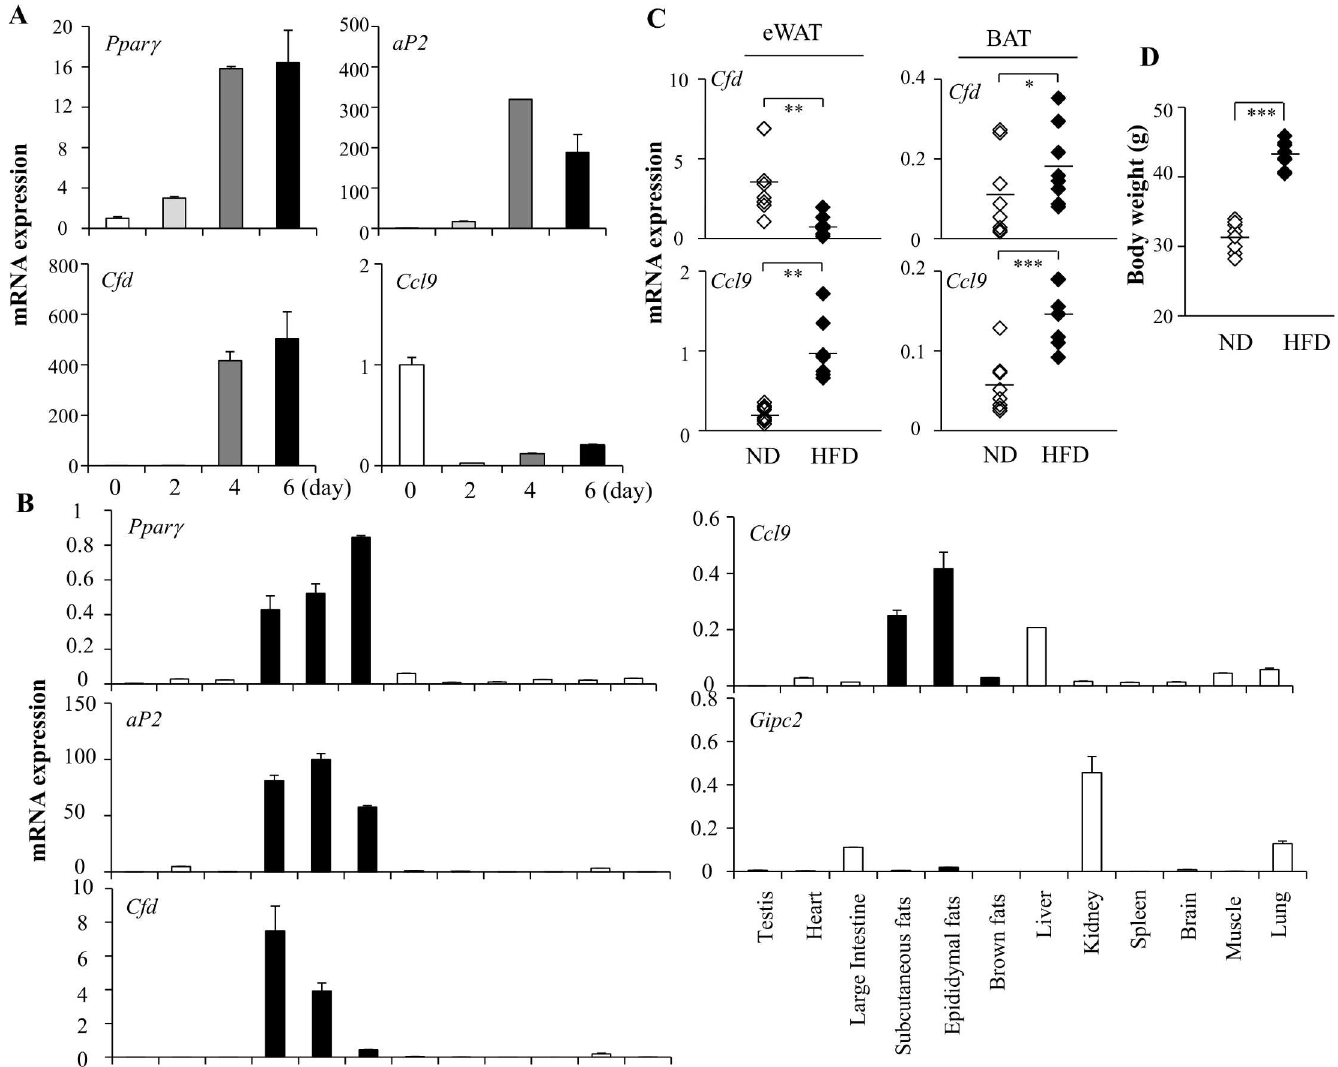
Fig 2. Expressionprofilesof Ccl9 and Cfd duringadipocytedifferentiationand in adiposetissues. ( A ) Inductionof Ppar γ , aP2 , Cfd , and Ccl9 by adipogenic cocktail in 3T3-L1cells. mRNA levels were assessed by real-time PCR at various timepoints over 6 days aftertreatmentwith a defined adipogenic cocktail includingdexamethasone, isobutylmethylxanthine, and insulin(DMI).( B ) Tissue distributionof Cfd , Ccl9 , Gipc2 , Ppar γ ,and aP2 in mice. mRNA expression was measuredby real-timePCR. Data shown represent the mean ± s.e.m (n = 3). ( C ) Ccl9 and Cfd mRNA expression in epididymalfat tissues (eWAT) and interscapular brown adipose tissues (BAT) was measuredin normaldiet-fed (ND)mice and high-fat diet-fed (HFD) obese mice. (D) Body weights of normaldiet and HFD fed mice. Data shown representthe mean +/- s.e.m (n = 8 per group).Statisticalsignificance was determinedrelative to a controlby the Student’s t -test( * P < 0.05; ** P < 0.005; *** P <